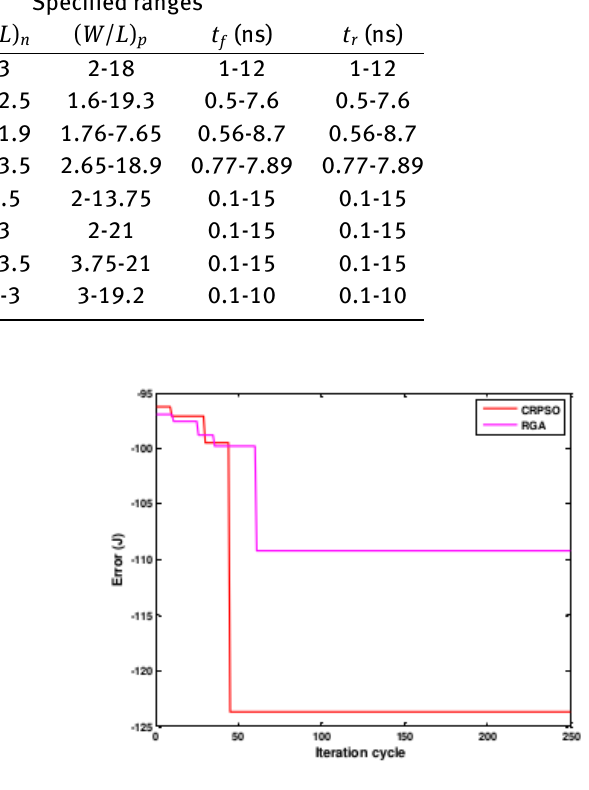
Figure 5: Plot of J versus iteration cycle for the fourth design set of Case